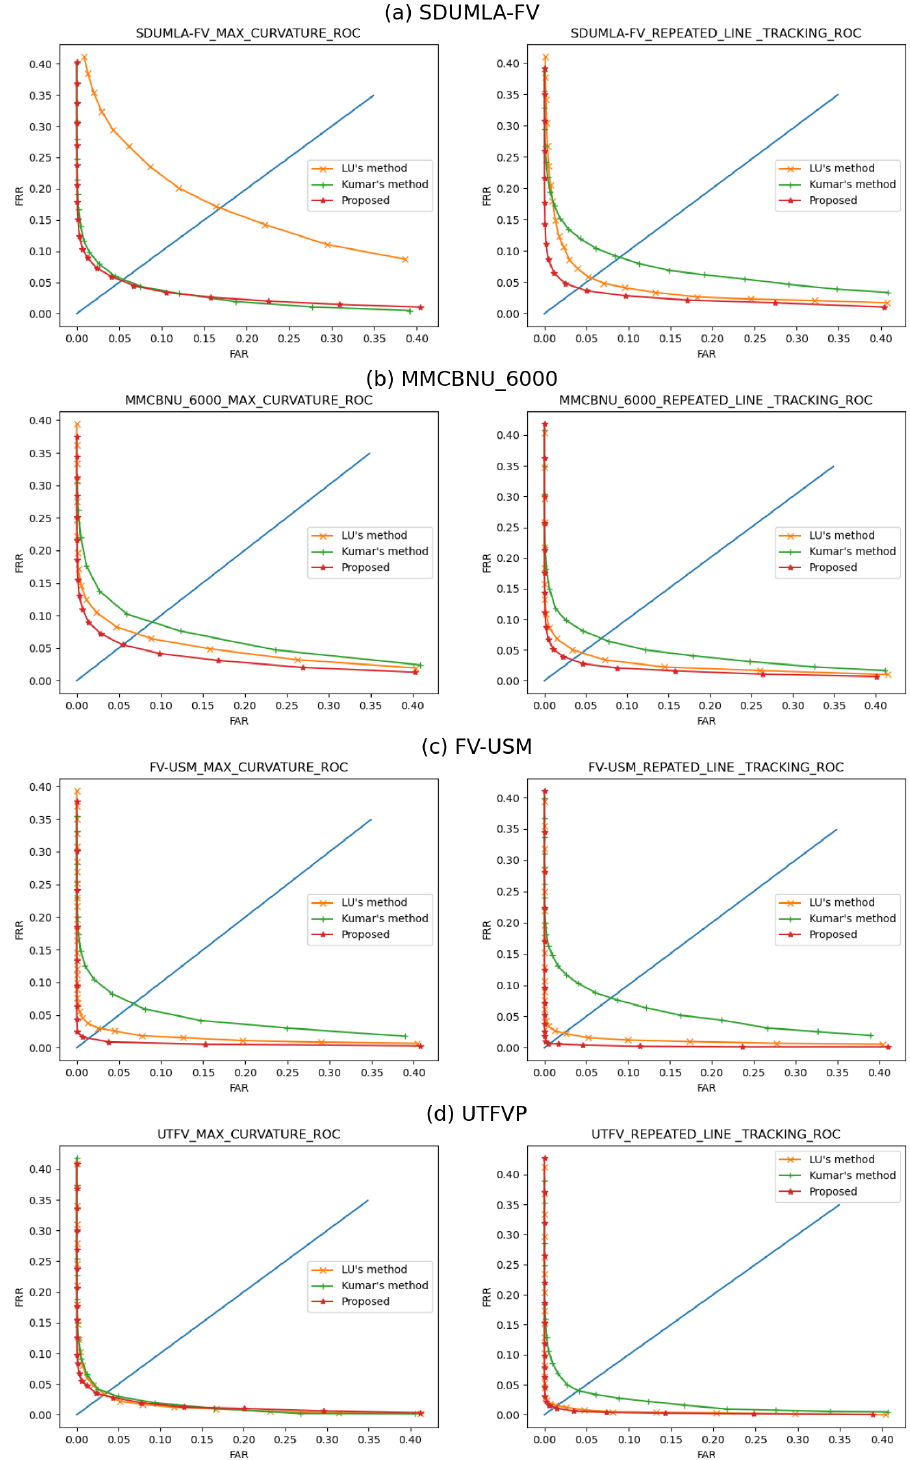
Figure 11. Comparisons of the ROC curves of different kinds of ROIs, obtained by using maximum curvature and repeated line tracking, respectively. ( a ) SDUMLA-FV, ( b ) MMCBNU_6000, ( c ) FV-USM, and ( d )